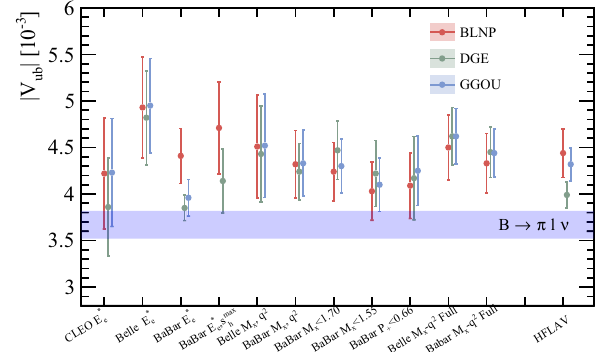
Fig. 8 Measurements of inclusive | V ub | and their averages based on BLNP, DGE and GGOU calculations. The HFLAV average of | V ub | results from B → π(cid:4)ν (cid:4) decay is also reported for